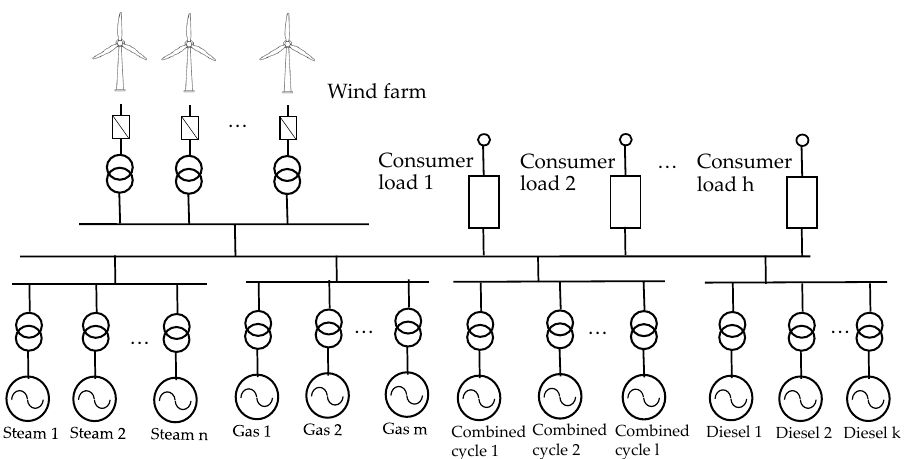
Figure 2. Simplified one-line diagram of the generic isolated power system.